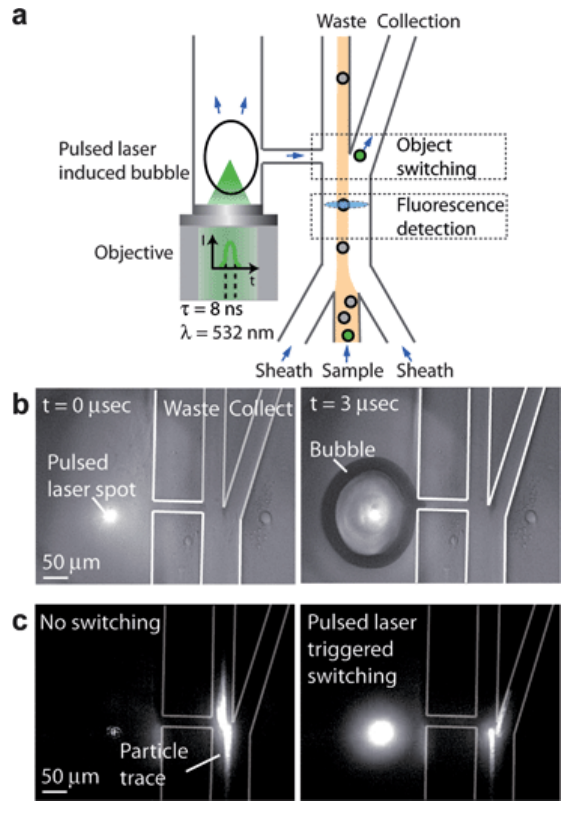
Figure 8. Schematic of the pulsed laser triggered high-speed microfluidic Fluorescence-Activated Cell Sorting (FACS). ( a ) When a fluorescent sample flows through the fluorescence detection region, a laser pulse is triggered and induces a cavitation bubble in the pulsed channel. The bubble expansion produces a high-speed liquid jet, directing the sample towards the collection channel for sorting. ( b ) Cavitation bubble generated by the focused pulsed laser beam in the microfluidic cell sorter at t = 0 µs and t =3 µs. ( c ) Fluorescent particle switching. When the fluorescence activated switching is not in use, the particle is directed towards the waste outlet. When the fluorescence activated switching is being used, the particle is directed towards the collection outlet. Reprinted with permission from [137]. Copyright (2012) Royal Society of